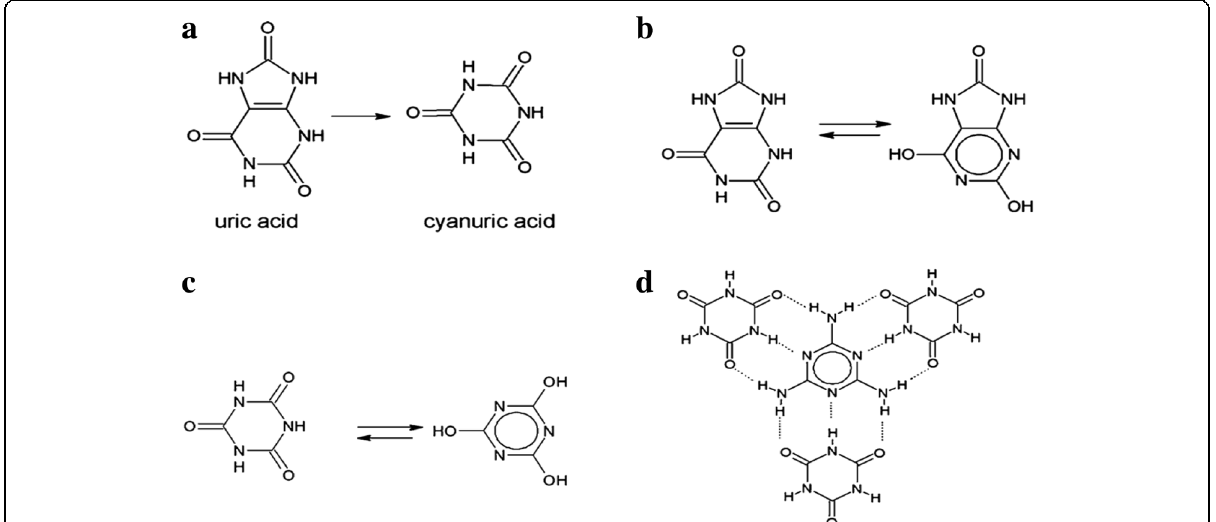
Fig. 9 ( a ) Thermal decomposition of uric acid to cyanuric acid; ( b ) tautomers of uric acid; ( c ) tautomers of cyanuric acid; ( d ) schematic representation of a layer fragment of the adduct called melamine